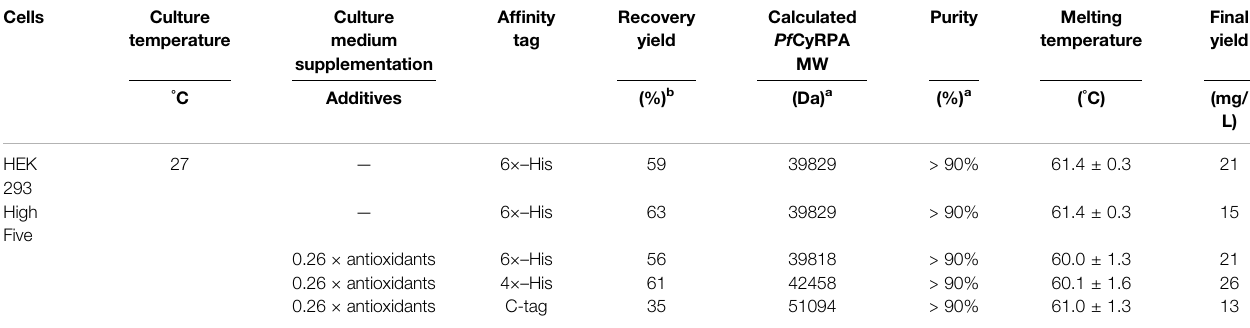
TABLE 2 | Effect of expression and puri fi cation parameters on Pf CyRPA yield and protein characteristics. Cells